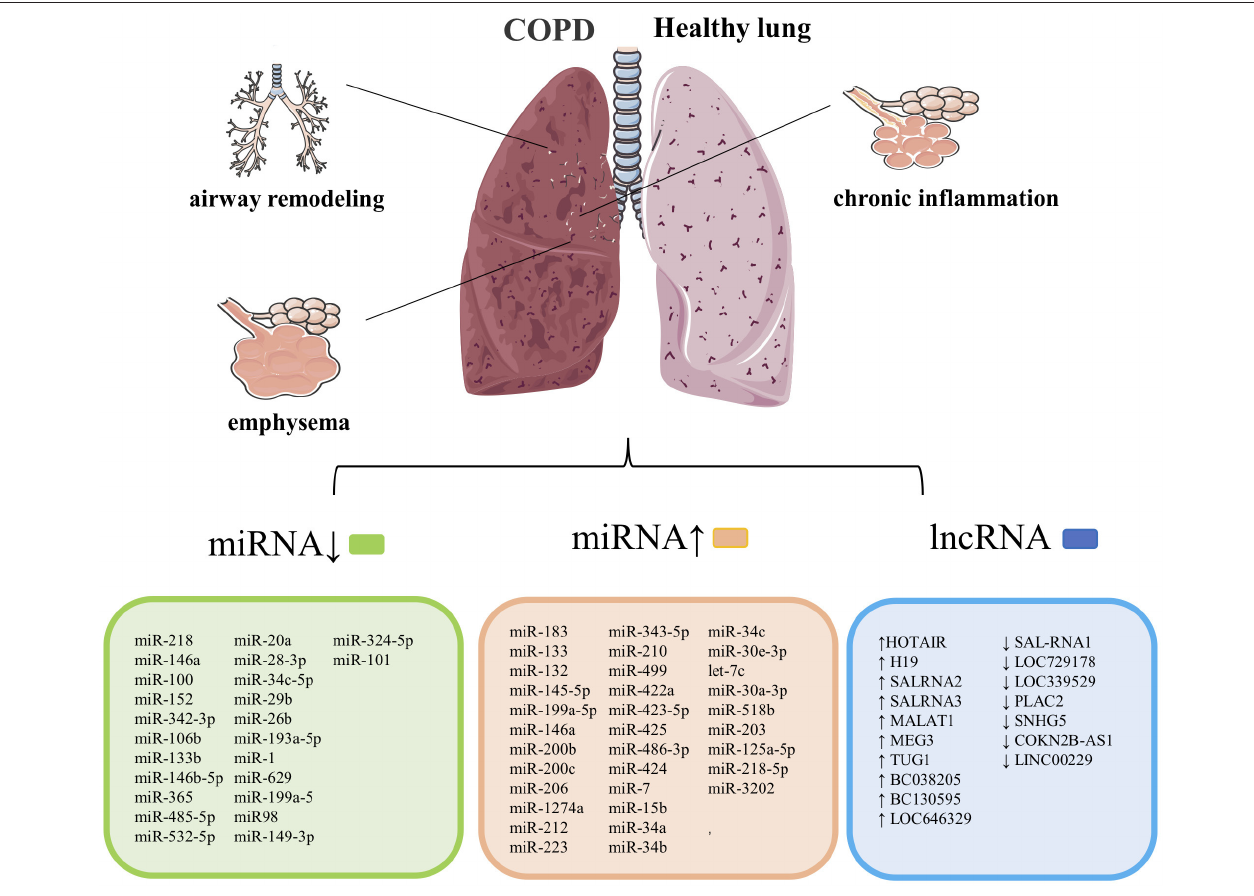
FIGURE 2 | COPD’s pathological features are chronic inflammation of the lung parenchyma and surrounding airways, emphysema, and narrowing. Remodeling of the small airways, and exosomes are closely related to the course of this cases. List of previously reported miRNA associated with COPD. COPD, chronic obstructive pulmonary disease. Summary data are based on the following references ( 4, 14, 15, 42–52) for miRNAs and (53–56) for